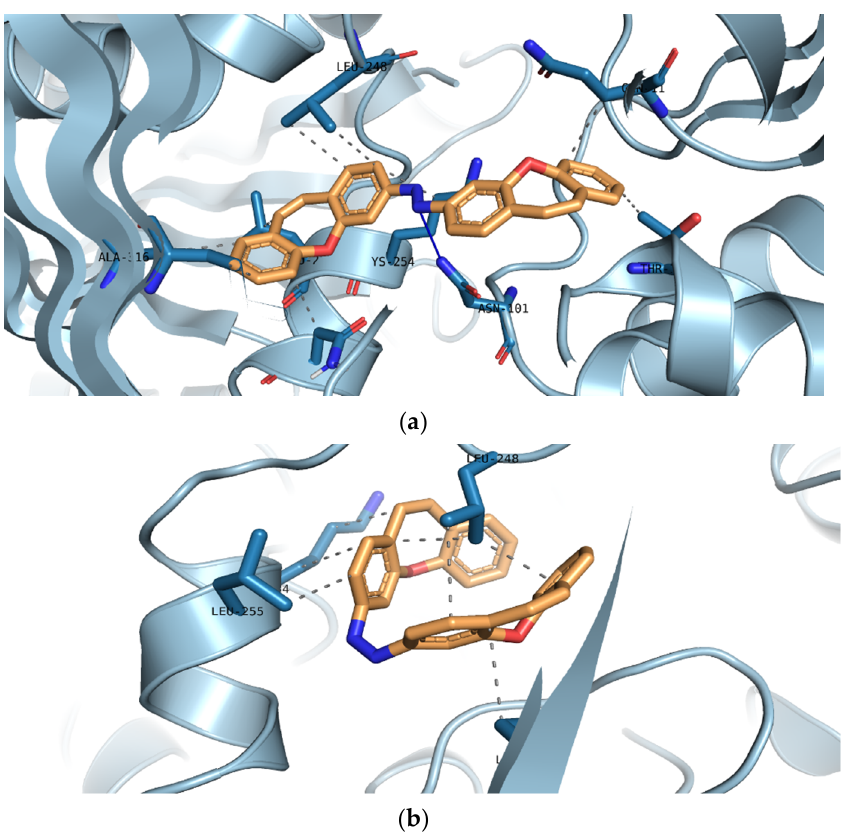
Figure 2. 3D model of the interaction between the isomers, E ( a ) and Z ( b ), of ( 2f ) and the colchicine binding site of α and β tubulin (crystal structure from PDB code: 1SA0).